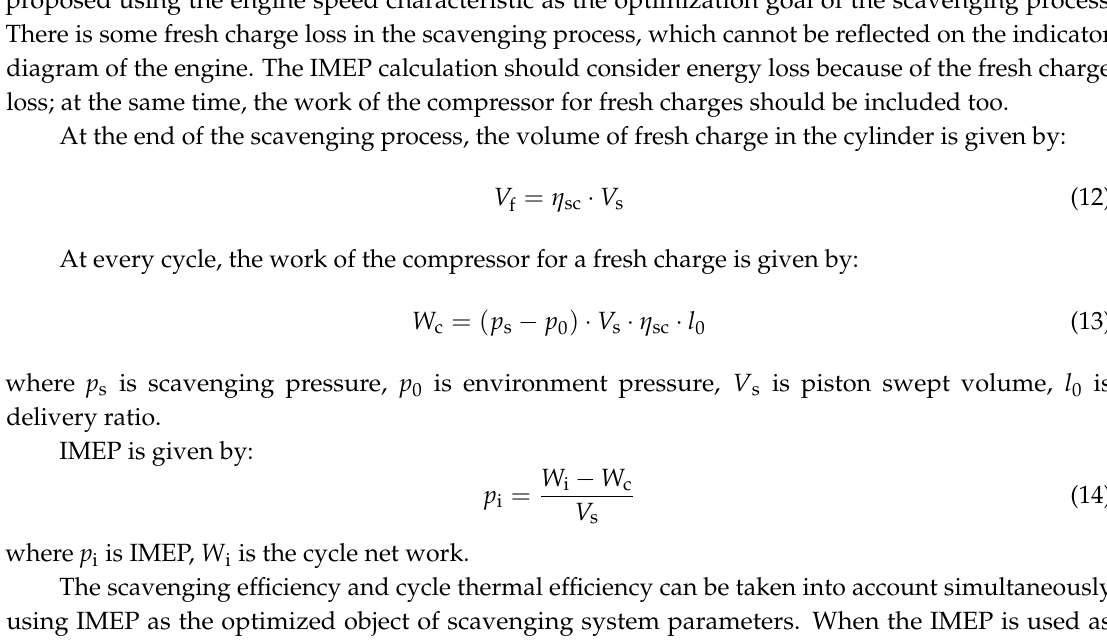
Figure 12. Effect of the port height and circumference ratio on working process ( a ) Intake port; ( b ) Exhaust port.